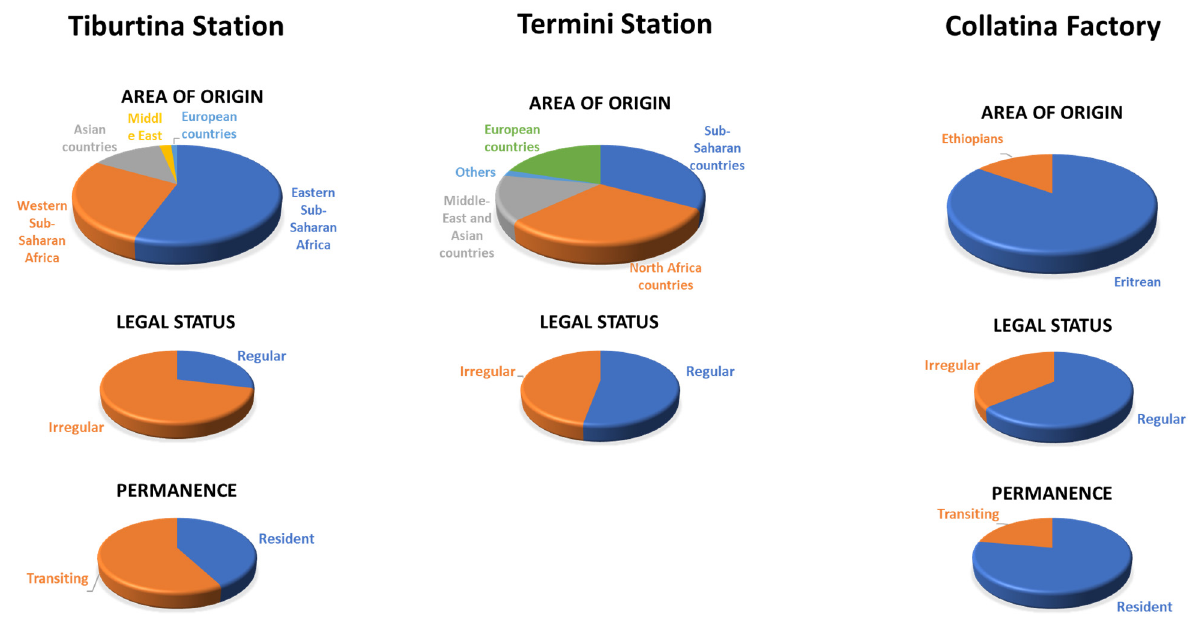
Figure 2. Population characteristic of the informal settlement of Rome. Area of origin, legal and permanence status vary depending on the type of settlement. Tiburtina settlement is made up mostly of transiting irregular migrants from sub-Saharan Africa. Termini station has a greater variability regarding the country of origin and the legal status of the population. In this settlement, visits were made only on the resident population. In Collatina, population comes from Ethiopia or Eritrea, and there was a higher percentage of regular and permanently resident populations than the other two settlements.